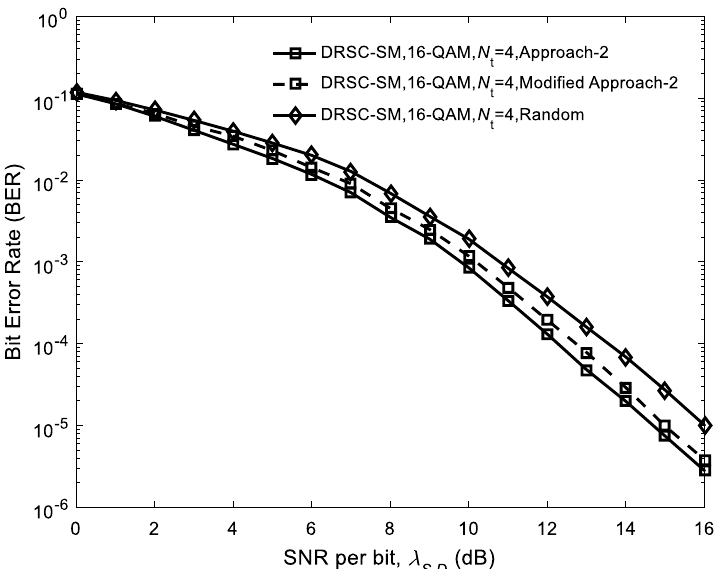
Fig. 8 Performance of DRSC-SM scheme (16-QAM) with RS 1 ( 63,61 ) and RS 2 ( 63,41 ) under different approaches. The solid line with diamond mark denotes the BER performance of DRSC-SM scheme under random approach. The solid line with square mark denotes the BER performance of DRSC-SM scheme under Approach 2. The dashed line with square mark denotes the BER performance of DRSC-SM scheme under modified Approach